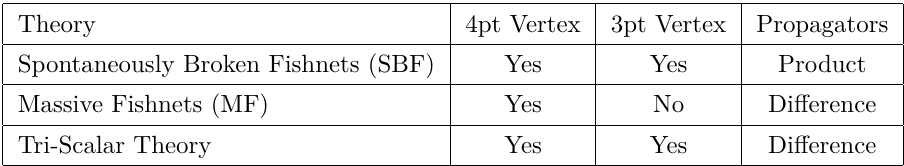
Table 1 . Comparison of the different massive extensions of the fishnet theory discussed